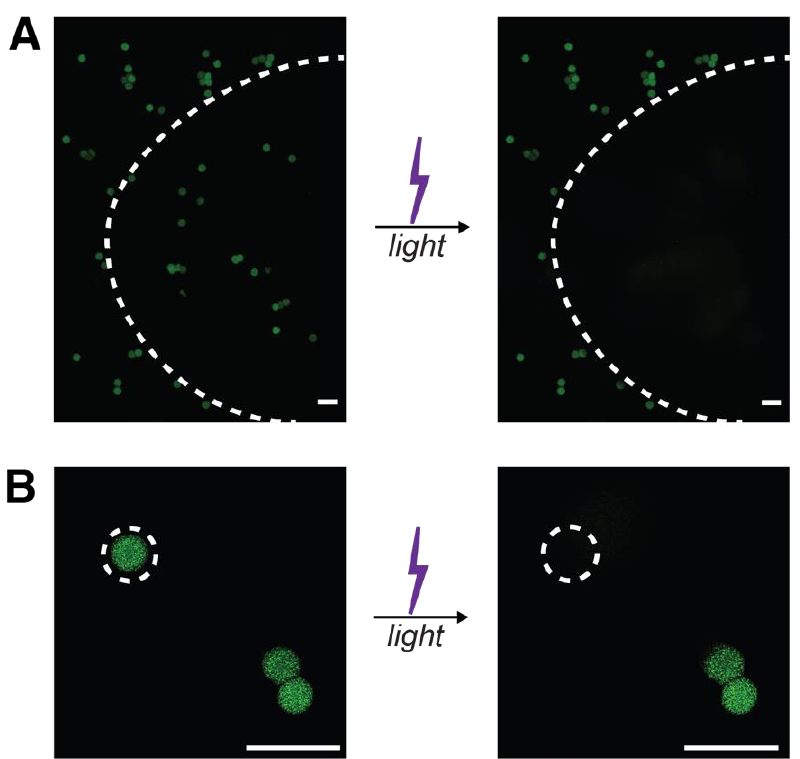
Figure 7. Degradation of light-responsive microgels . Light-responsive microgels loaded with BSA-AF488 were degraded by either flood ( A ) or targeted ( B ) long-wavelength UV light irradiation ( λ = 300 – 400 nm; I 0 = 1.5 mW cm − 2 ; t flood = 30 s; t target = 10 s). Areas of light exposure are shown by dashed lines, where irradiation was performed through a 20× objective for flood irradiation and 40x objective with a partly closed aperture for targeted irradiation, and then imaging of the wider field of view was performed with a 10× or 20× objective, respectively. Scale bars = 200 µm.